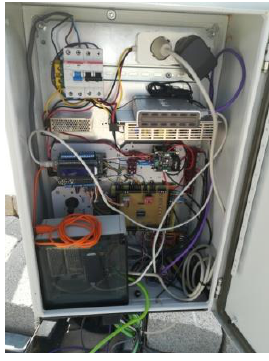
Figure 9. Controller.